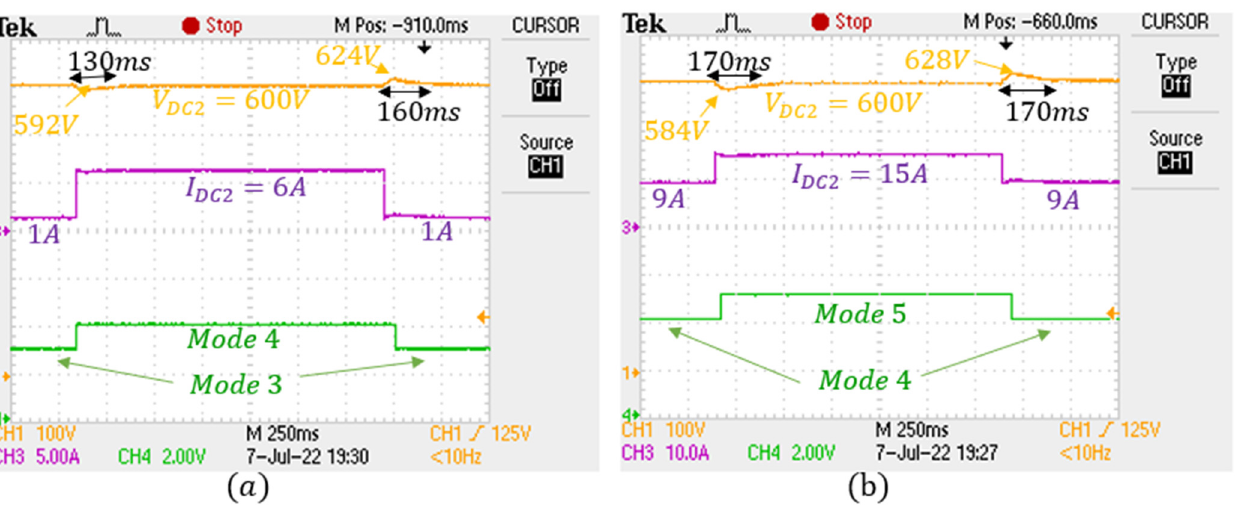
The maximum overshoot for this simulation was ( | 628 − 600 | ) /600 = 4.7% and